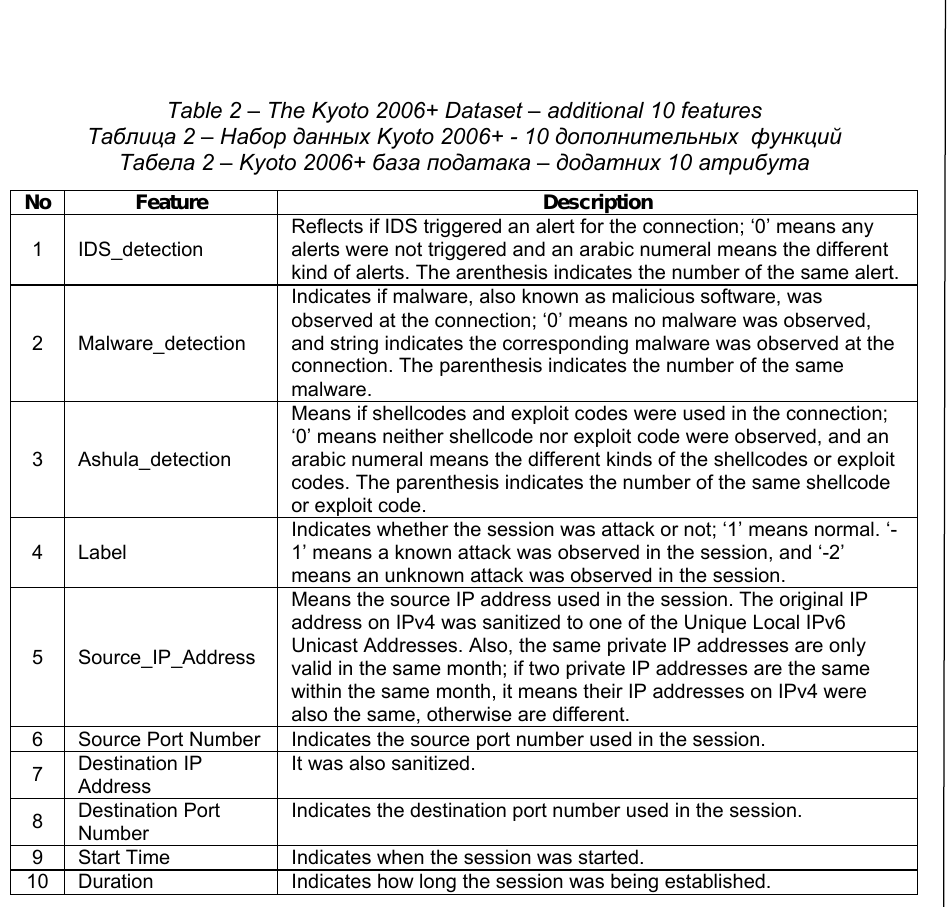
Таблица 2 – Набор данных Kyoto 2006+ - 10 дополнительных функций Табела 2 – Kyoto 2006+ база података – додатних 10